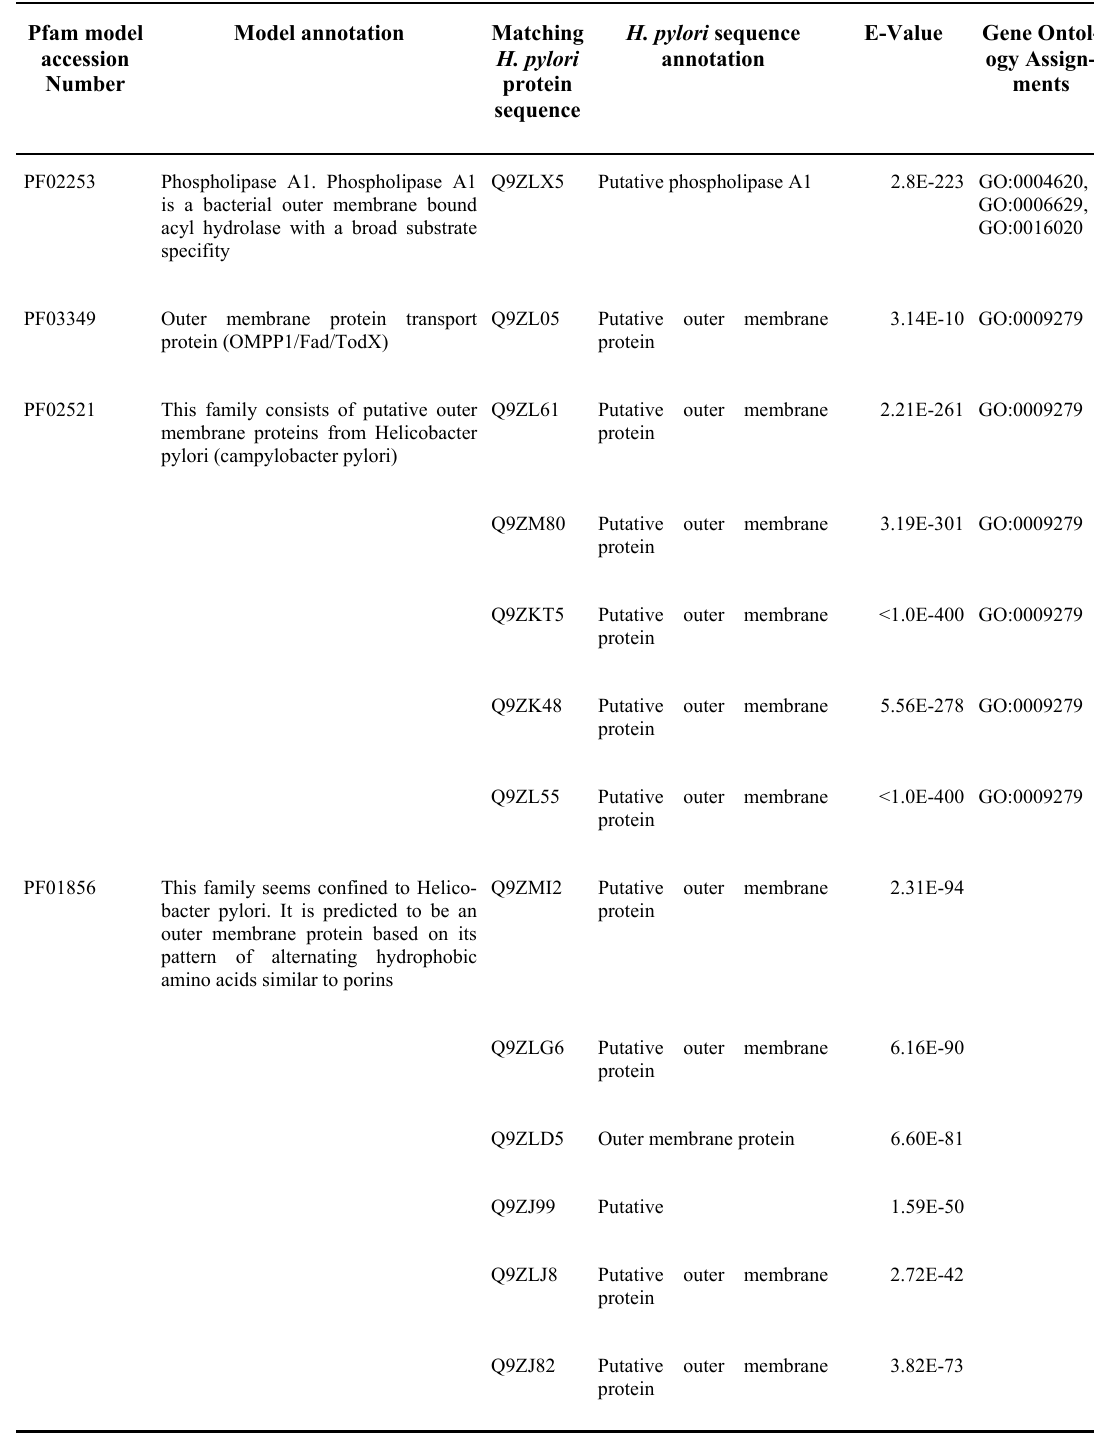
Table 7: Outer membrane proteins of H. pylori with no homologs in eukaryotes. Pfam